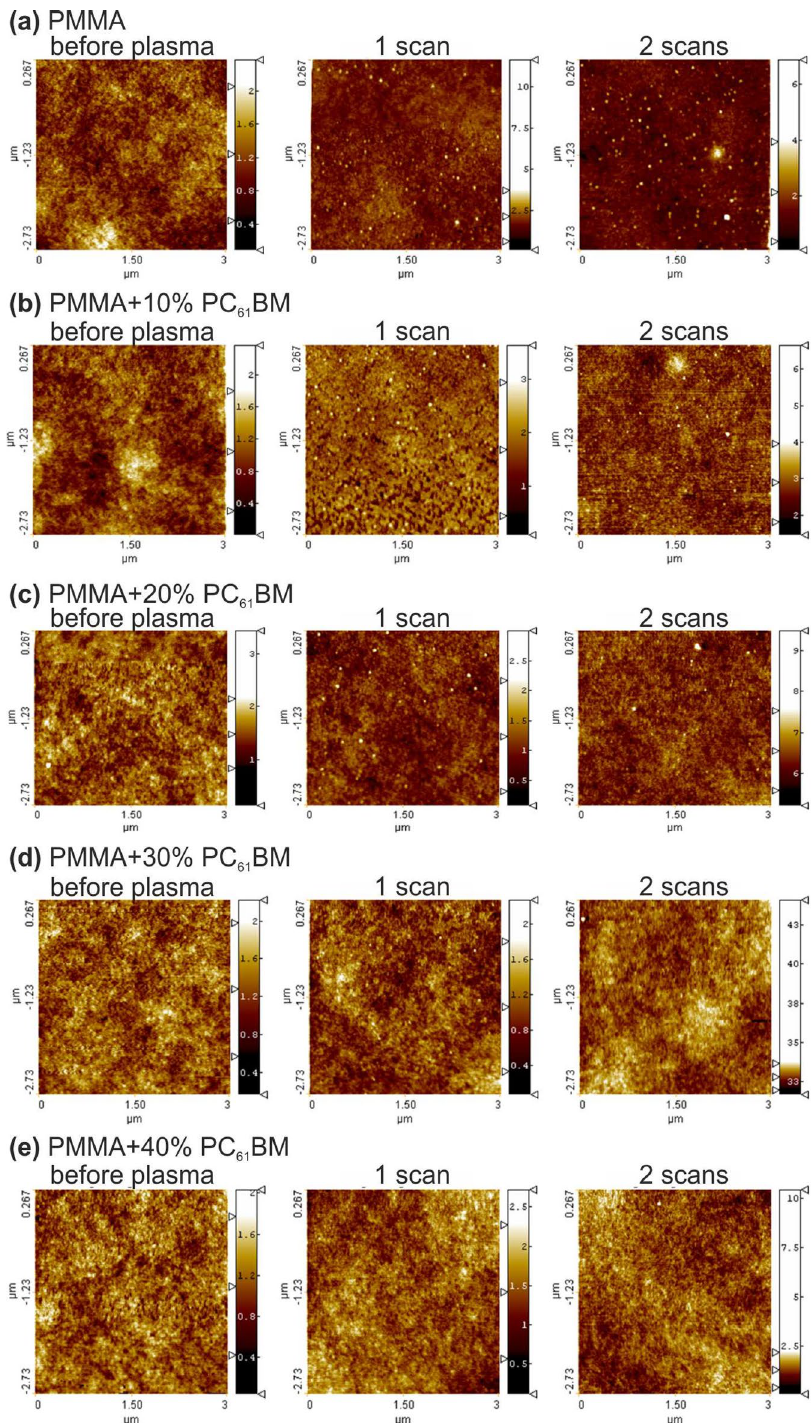
Figure 8. AFM acquired images of untreated and plasma treated PMMA polymer and PMMA + PC 61 BM composites. Argon flow rate 16 NL/min. Microwave power 330